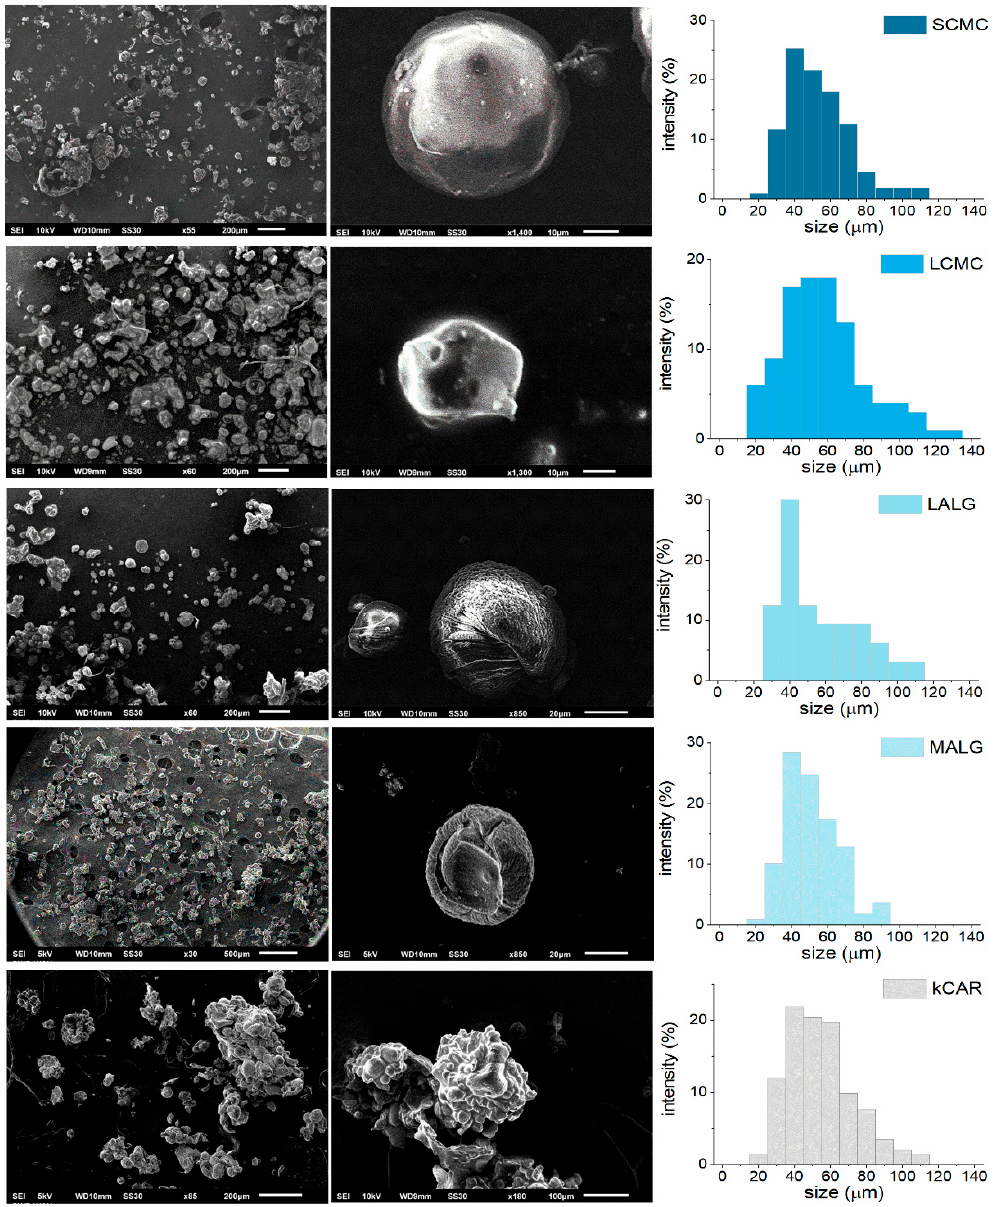
Figure1. Scanningelectronmicroscopyimagesandsizedistributionofthecranberryextract(CE)-loaded Figure 1. Scanning electron microscopy images and size distribution of the cranberry extract (CE)- polysaccharide loaded polysaccharide microparticles.